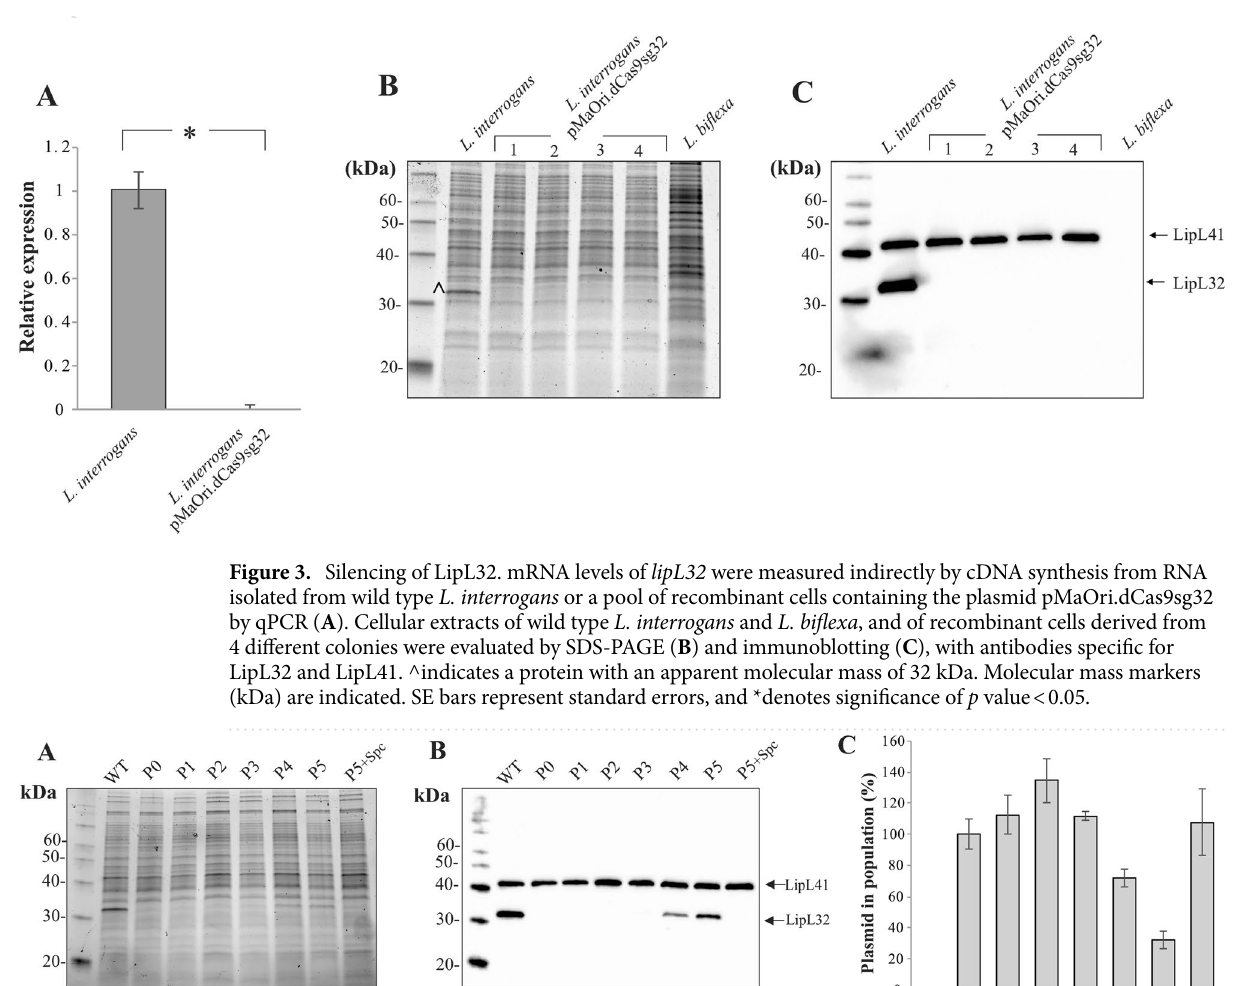
number of plasmids per cell is approximately 1, as determined by qPCR of cells from passage number 0, and comparing Ct values displayed by lipL32 and pMaOri amplifications curves (data not shown). LigA and LigB silencing in L. interrogans decreases bacterial survival upon serum chal‑ lenge. Our results thus far highlight the application of CRISPRi to specifically silence a gene highly con- served amongst pathogenic species of leptospires. To further validate the use of CRISPRi as a universal tool to target any gene of choice, the concomitant silencing of both LigA and LigB in L. interrogans was performed by designing a sgRNA capable of pairing to a conserved region in the coding strand for both ligA and ligB , Table 1. By applying the optimized conjugation protocol as described above, an average of 25 colonies per plate, after 8 days, were obtained when L. interrogans was transformed with pMaOri.dCas9 and pMaOri.dCas9sgLigAB. Transconjugants were confirmed by PCR (data not shown). Selected colonies were grown in liquid HAN media and evaluated for the expression of LigA and LigB by immunoblotting with anti-LigA/B antibodies. When both dCas9 and specific sgRNA for ligA and ligB of L . interrogans were expressed, no LigA nor LigB protein could be detected in whole cell extracts, Fig. 5A,B. Both LigA and LigB of L . interrogans have been extensively characterized. In contrast to L . interrogans , the genome of the pathogenic species L . borgpetersenii contains ligB , but not ligA . An sgRNA designed specifically for ligB of L . borgpetersenii , contained in pMaOri.dCas9sgLigBMismatch and which differs from that of the